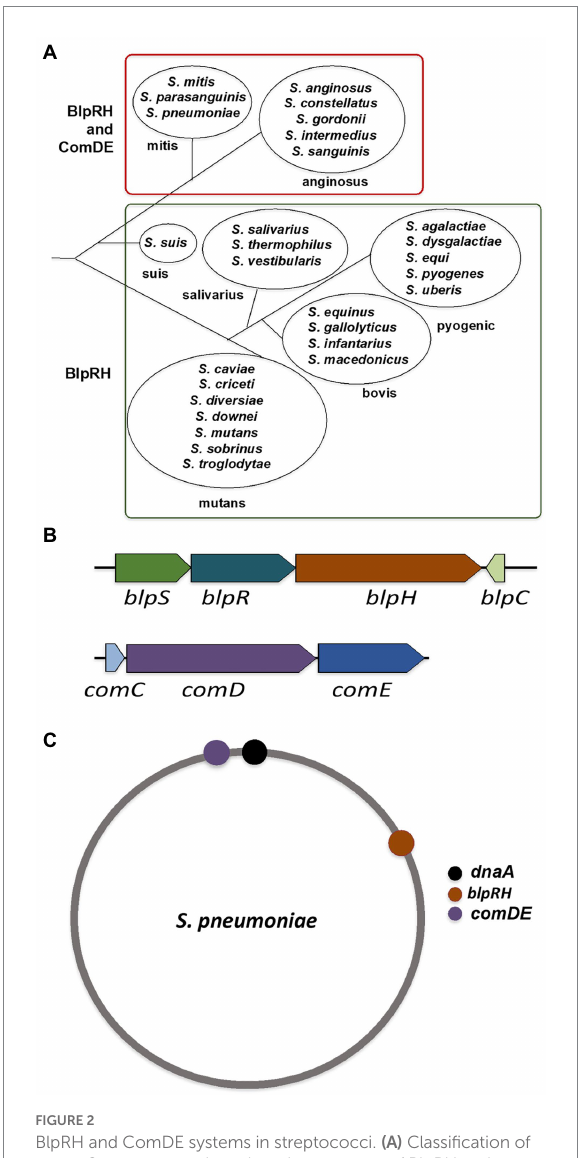
FIGURE 2 BlpRH and ComDE systems in streptococci. (A) Classification of genus Streptococcus based on the presence of BlpRH and ComDE. A phylogenic tree of major species is shown (branch lengths are not to the scale). The groups mitis and anginosus encode both the TCS pathways containing HPK-10 subfamily proteins (BlpH and ComD), classified as a class B group. While the other groups such as suis, mutans, salivarius, bovis, and pyogenic encode only the BlpRH system, classified as a class A group. (B) Schematic representation of the operon structure of BlpRH and ComDE systems. Gene annotation is according to the NCBI designation. Note that some BlpRH systems often encode an additional gene, blpS , upstream of blpR . (C) Localization of BlpRH and ComDE systems on the genome of Streptococcus pneumoniae . The BlpRH is located on the first quadrant while the ComDE is located on the fourth quadrant, near the